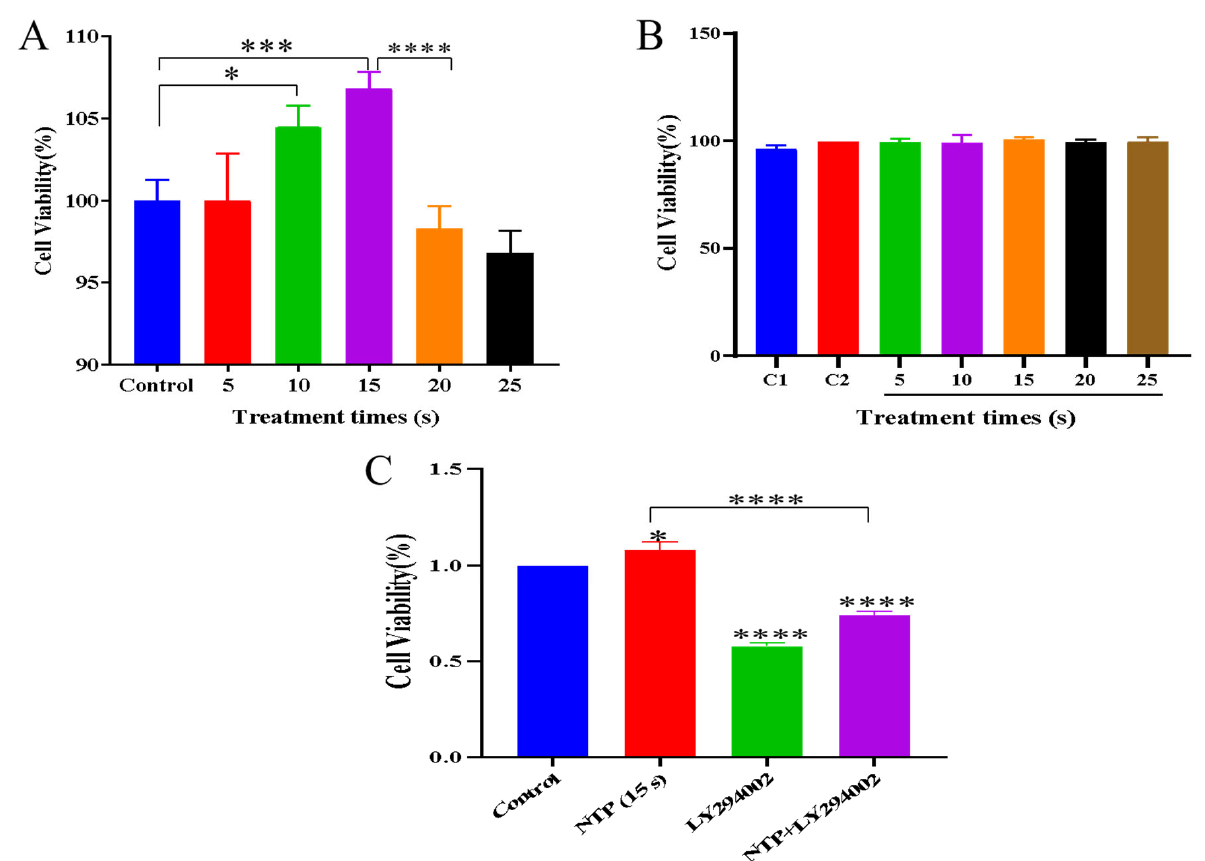
Figure 1. Cell viability of HaCaT cells. ( A ) HaCaT cell viability after NTP treatment for 24 h. ( B ) Effect of NTP on the viability of HaCaT cells pre-incubated with NAC. ( C ) Effect of PI3K inhibitor LY294002 on cell viability. C 1: cells given neither NAC nor NTP treatment; C 2: cells treated with NAC in the absence of NTP treatment. Data represent the mean ± SD of three independent experiments. * p < 0.05, *** p < 0.001, **** p < 0.0001 with ANOVA compared with the control.